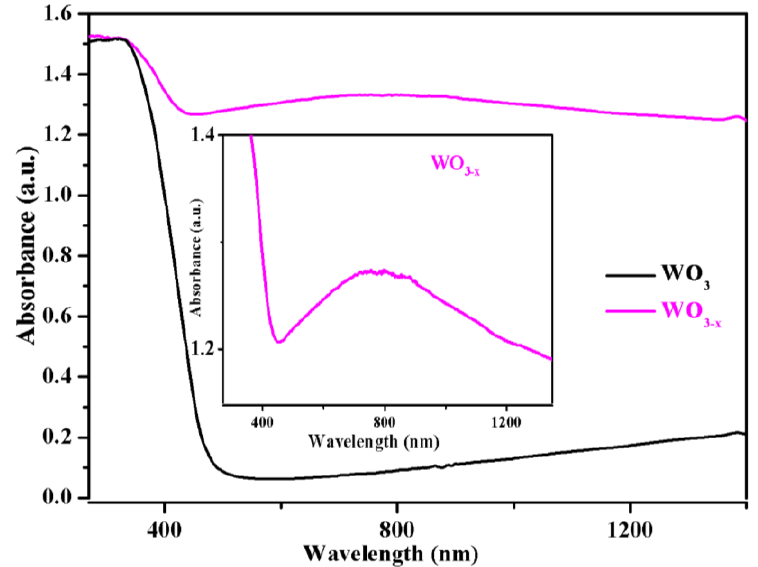
Figure 4. UV-Vis diffuse reflectance spectra of the WO 3 and WO 3 − x